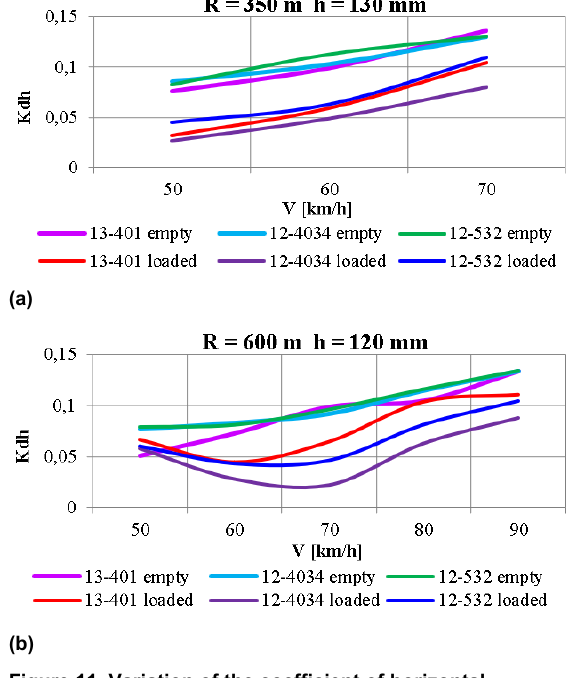
Figure 11. Variation of the coefficient of horizontal dynamics with the motion speed: (a) R=350 m curve; (b) R=600 m curve